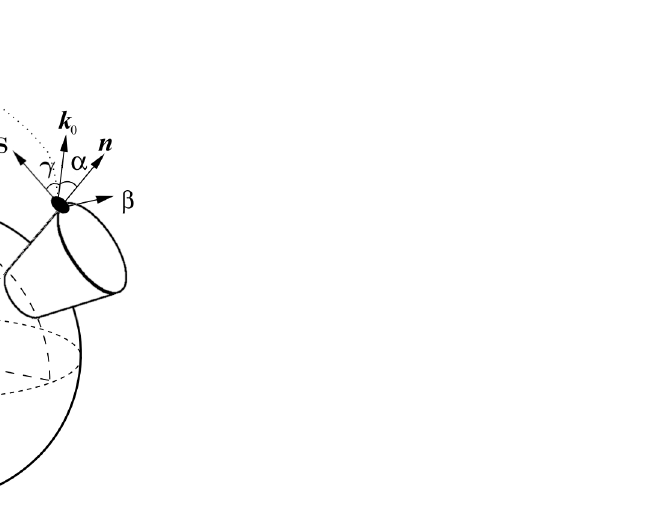
Figure 2. The coordinate system adopted for a photon leaving in the (cid:126) k 0 direction from a small region with area dS on the side of the cone trunk accretion column of the neutron star. The rotational axis is the z-axis, (cid:126) k points towards the observer, and (cid:126) β is the